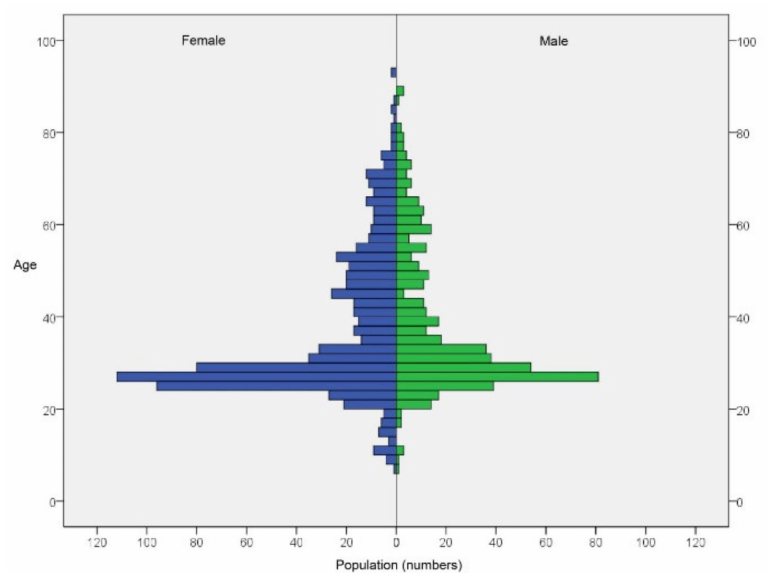
Figure 1. Age and gender distributions of